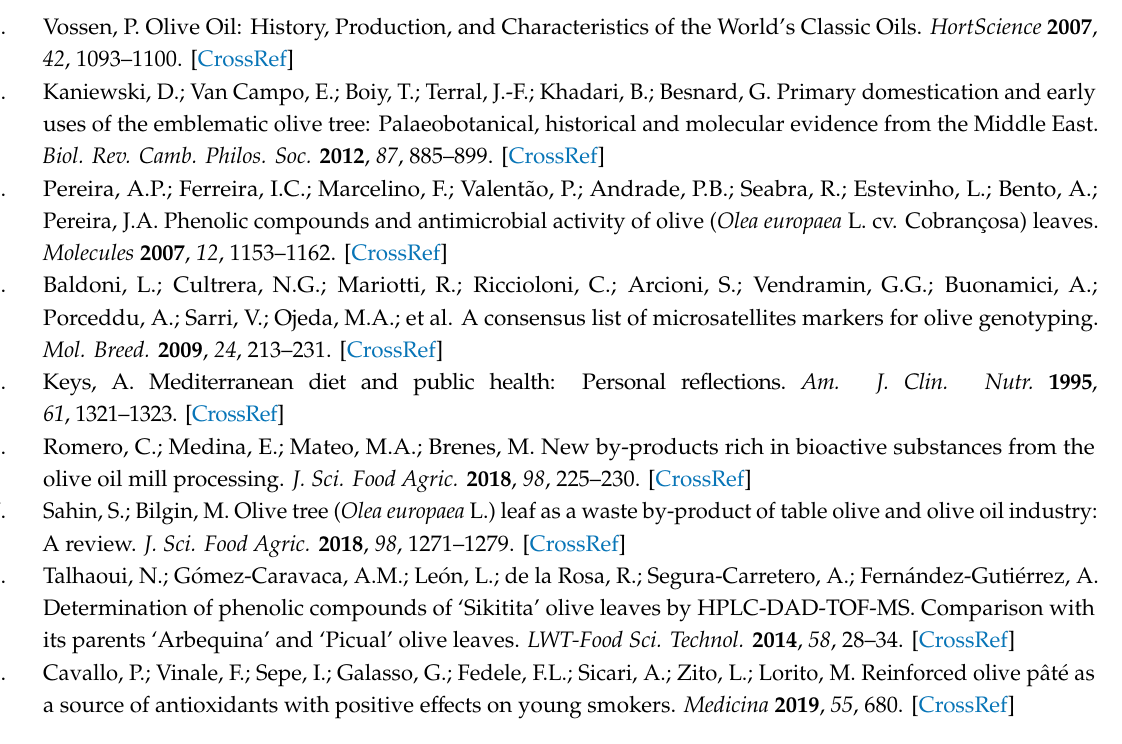
Figure S1: Chlorophyll content in olive leaves of plants treated with Trichoderma strains (M10, KV906, GV41, TH1, and T22) or secondary metabolites (6PP and HA). Figure S2: Schematic and simplified representation of olive secoiridoid pathway. Table S1: Comparison of metabolites in di ff erent olive leaf metabolomes whose accumulation increased (UP) or decreased (DOWN) compared to control (CTRL) after 5 field applications with Trichoderma strains or metabolites. Table S2: List of primers used in this study. Table S3: Analytical parameters of the commercial standards used for the quantification of phenolic compounds in olive leaf